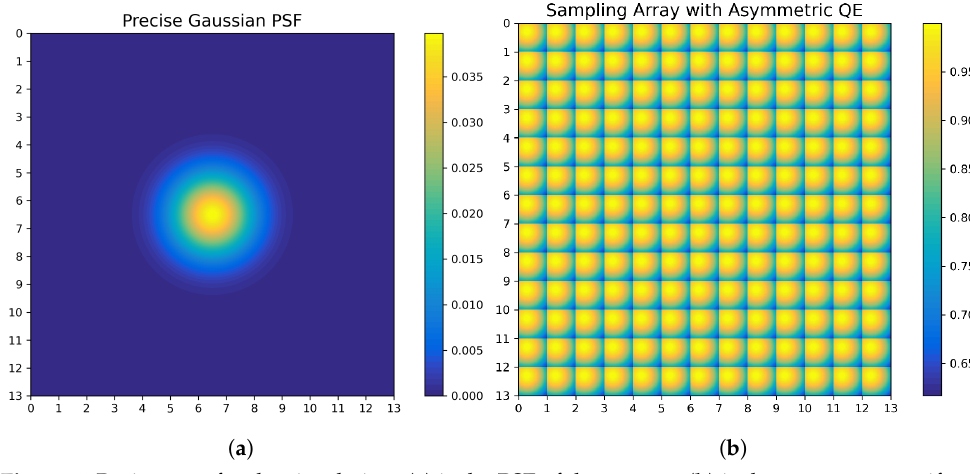
Figure 4. Basic setup for the simulation. ( a ) is the PSF of the system. ( b ) is the response to uniform illumination by the asymmetric QE array, which represents the intra-pixel sensitivity distribution for the simulated asymmetric integral sampler